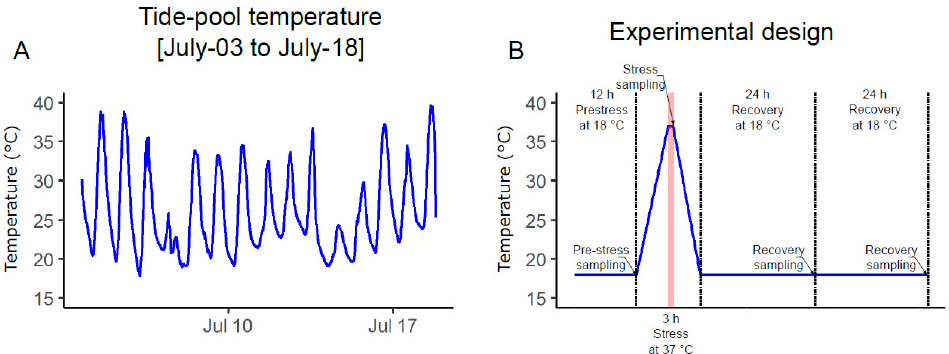
Figure 1. Thermal-stress experimental design. ( A ) Field temperature measurements within a tide- pool in Great Sippewissett Marsh (Massachusetts, 41°35 ′ N 70°39 ′ W) over 15 days (3 July to 18 July) representing the natural fluctuations in the field at the time of the experiment. ( B ) Schematic repre- sentation of the experiment. Field-conditioned N. vectensis and lab-cultured N. vectensis triplicates were sampled over 72 h at 4 time points, indicated by arrows; the two groups were introduced to stress of 37 °C for 3 h (marked in red) and then sampled after recovery.